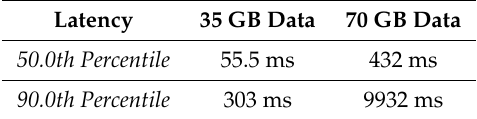
Figure 14. Maximum capacity reached for 200 concurrent users (threads at 10 queries/s). Table 6. Impact of data size on spatial query latency.